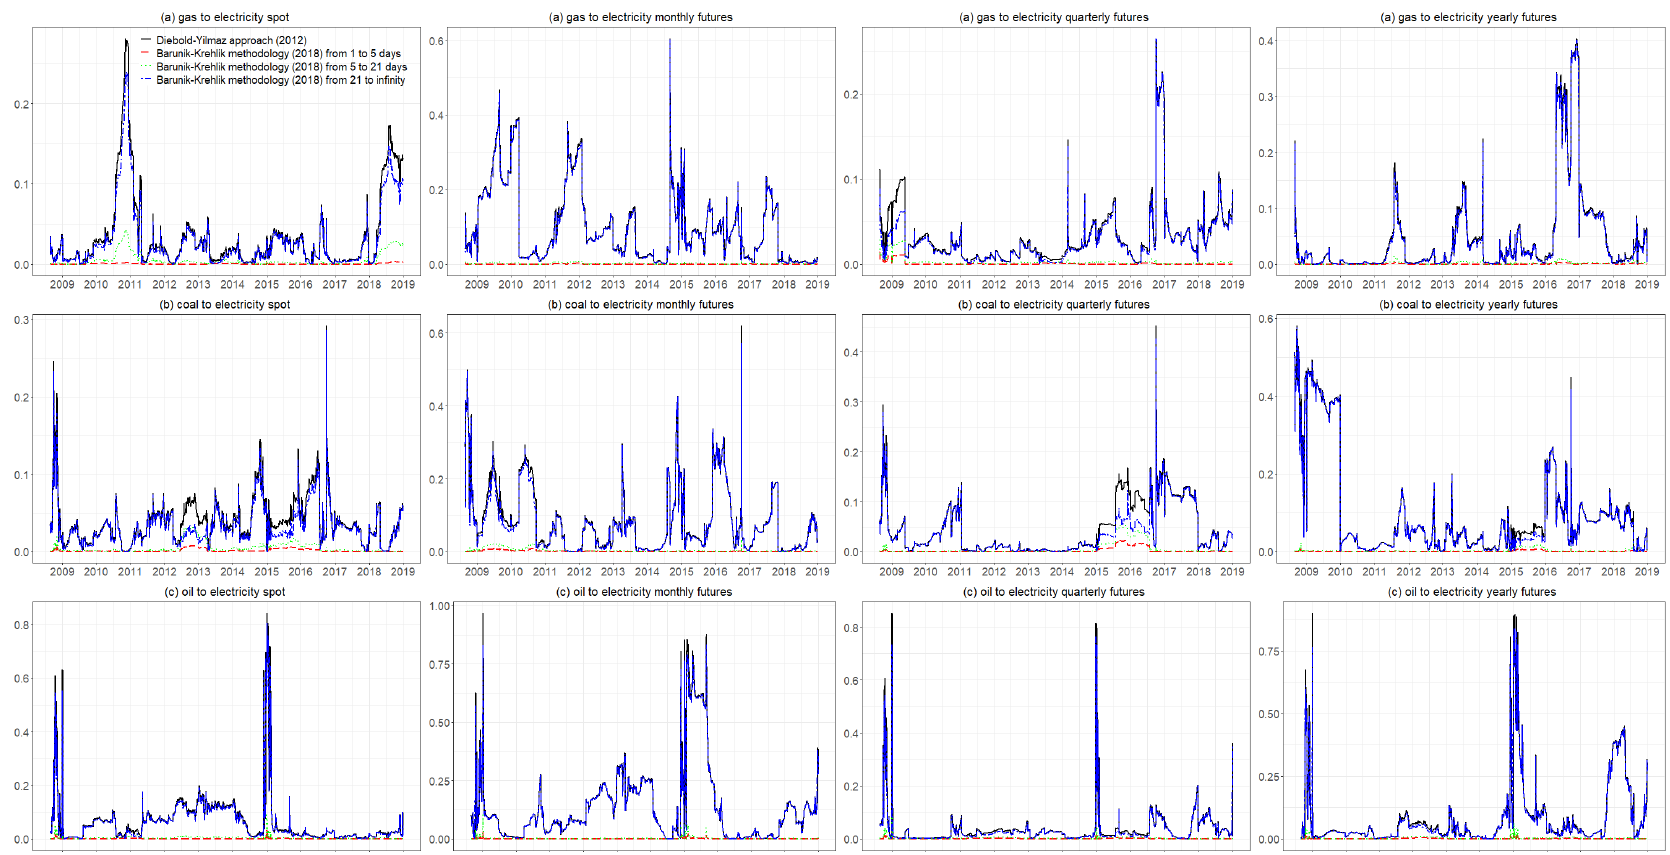
Figure A2. Diebold – Yilmaz approach (2012) directional volatility spillover (Pairwise) and Barunik – Krehlik methodology (2018) directional volatility spillover (Pairwise). Figure A2. Diebold–Yilmaz approach (2012) directional volatility spillover (Pairwise) and Barunik–Krehlik methodology (2018) directional volatility spillover